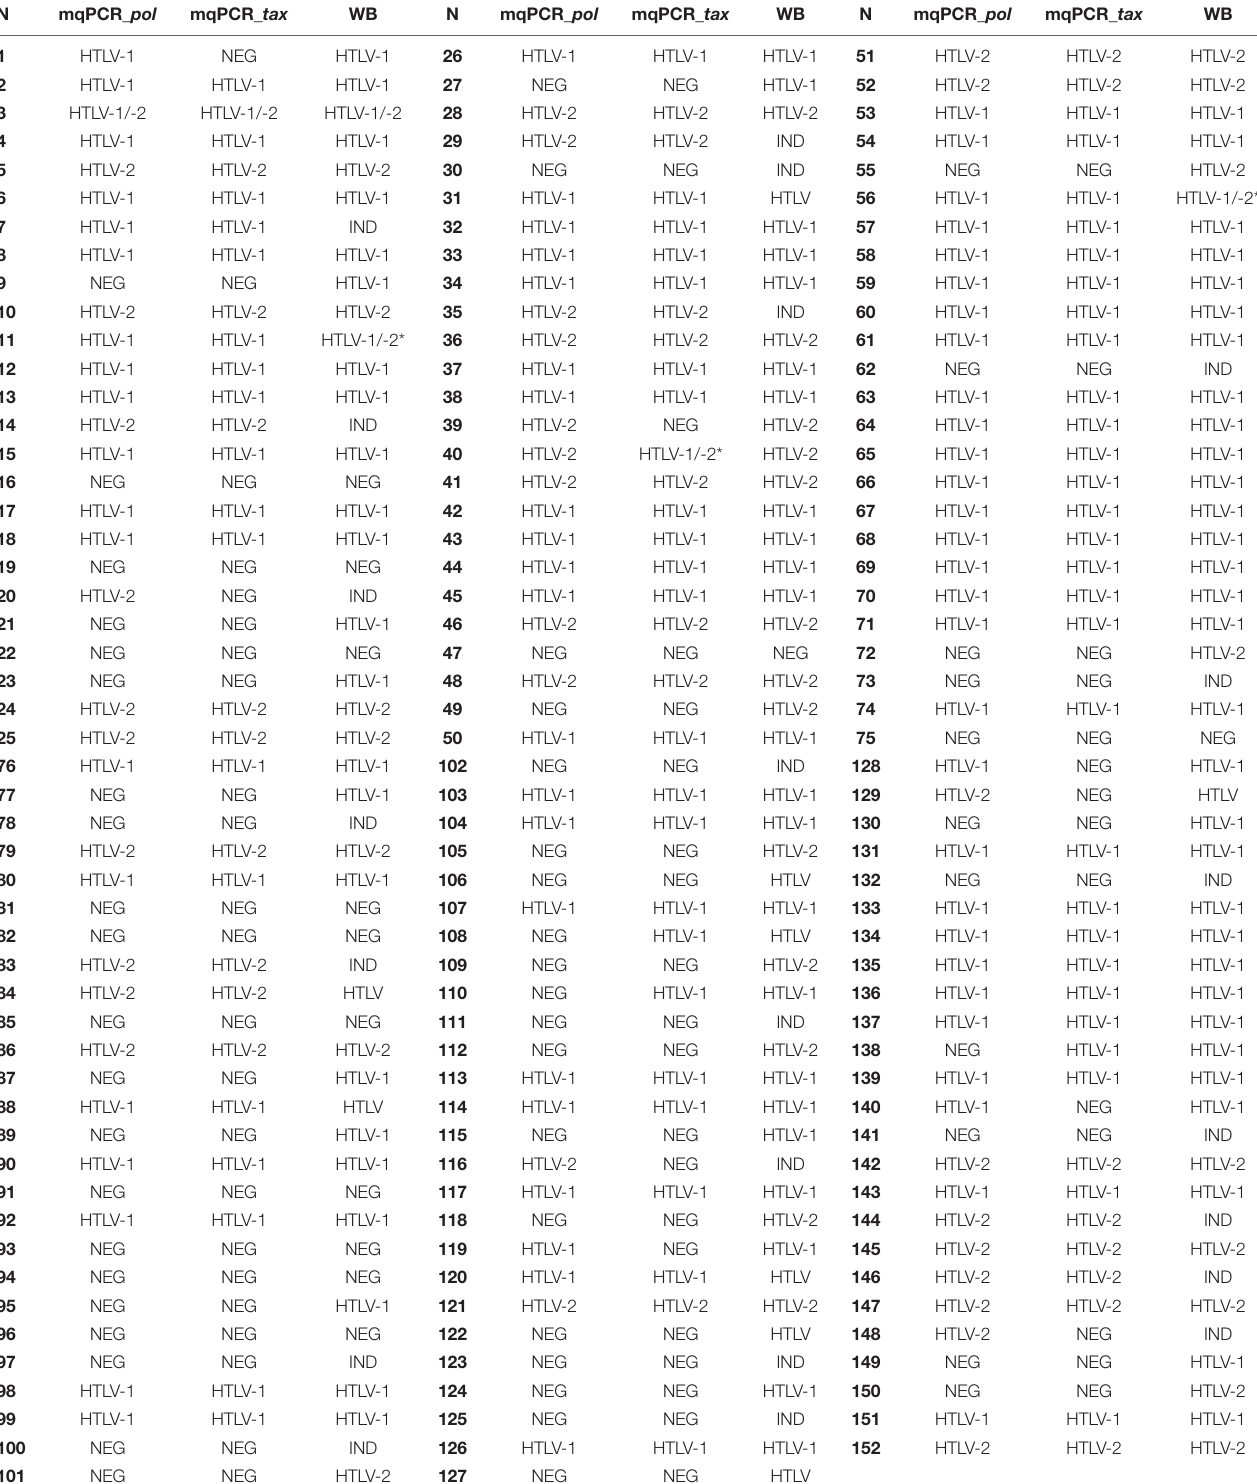
TABLE 7 | Final results of HTLV-1/2 confirmatory tests (mqPCR_HTLV pol and tax , WB when employed in 152 HIV-infected individuals suspected of HTLV-1/2 infection by screening assays (Group